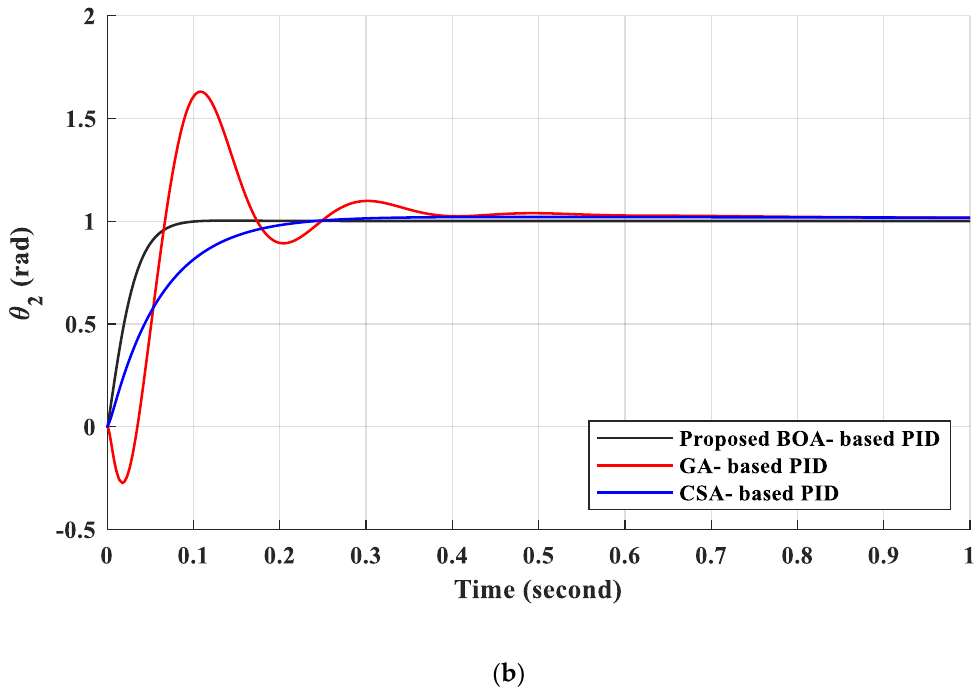
Figure 11. The output position in case of decreasing the parameters by −20% ( a ) the position of link 1 , ( b ) the position of link 2 .